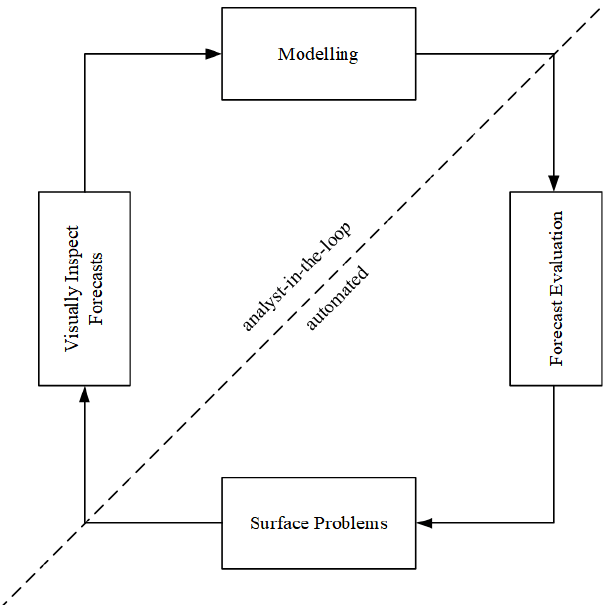
Figure 2. Modeling process of Prophet.